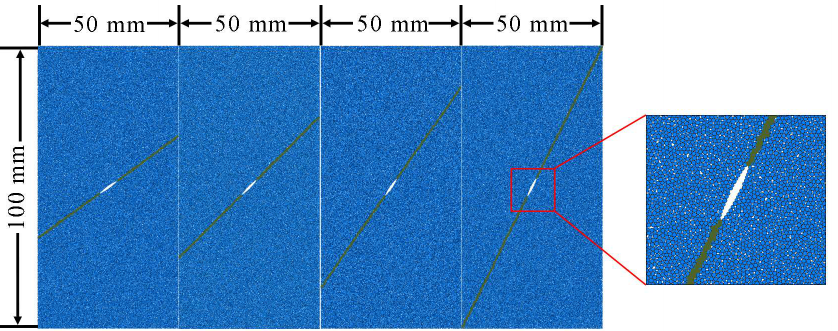
Figure 5. Interface crack specimens with different joint inclination angles (the inclination angles of the joint, from left to right, are: 35.8°, 45°, 54.2°, and